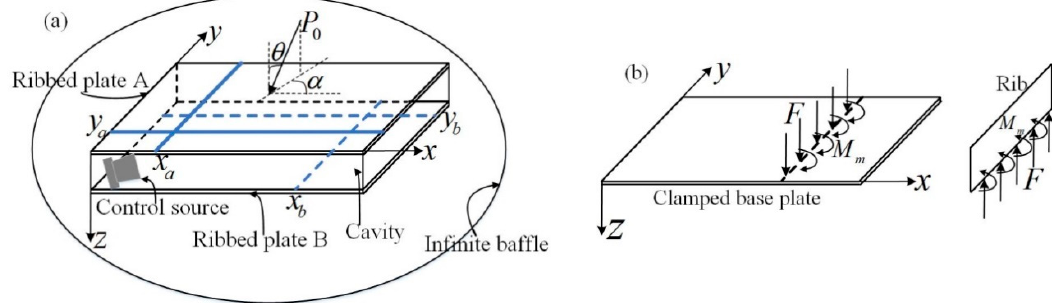
Figure 1. Sketch of the model. ( a ) Active sound insulation double-panel system. ( b ) Sketch of coupling effects in connection line between the base plate and the rib.